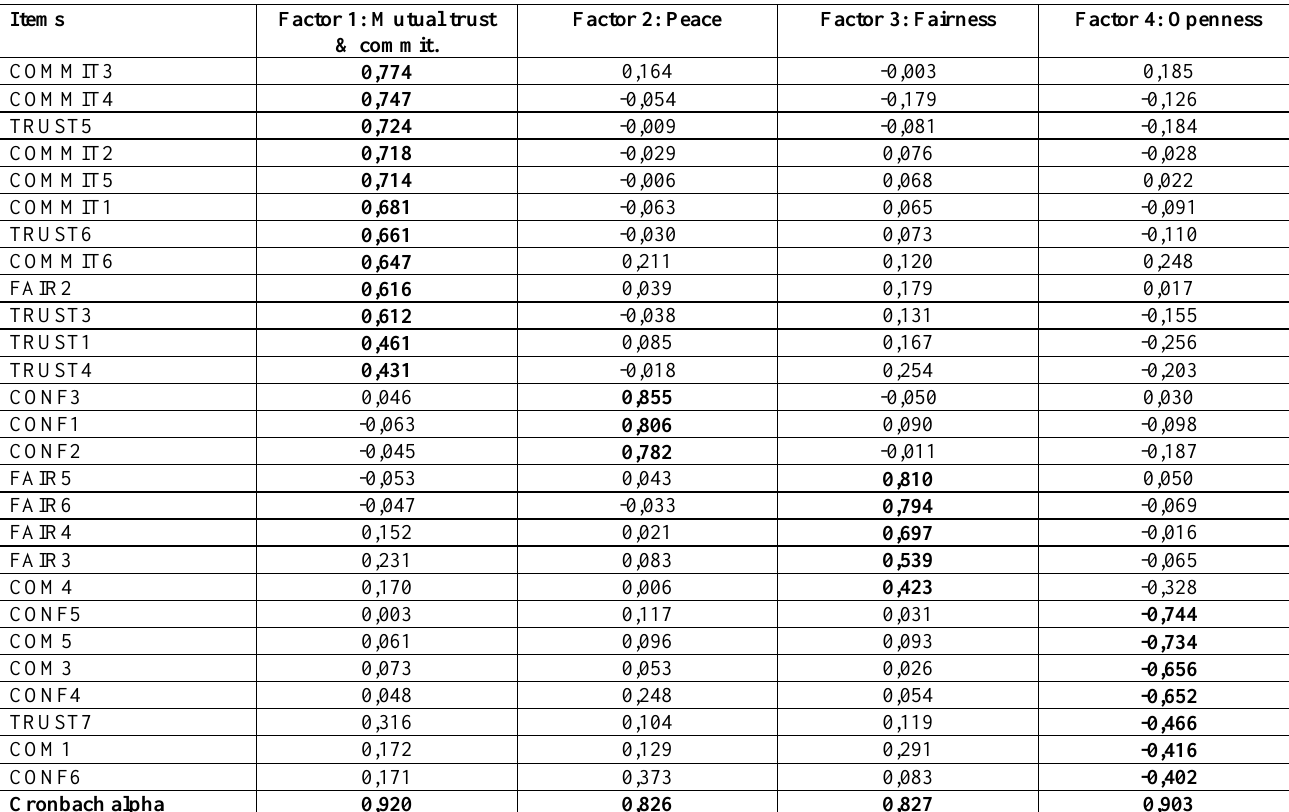
Table 2: Oblimin rotated factor matrix: Independent variables